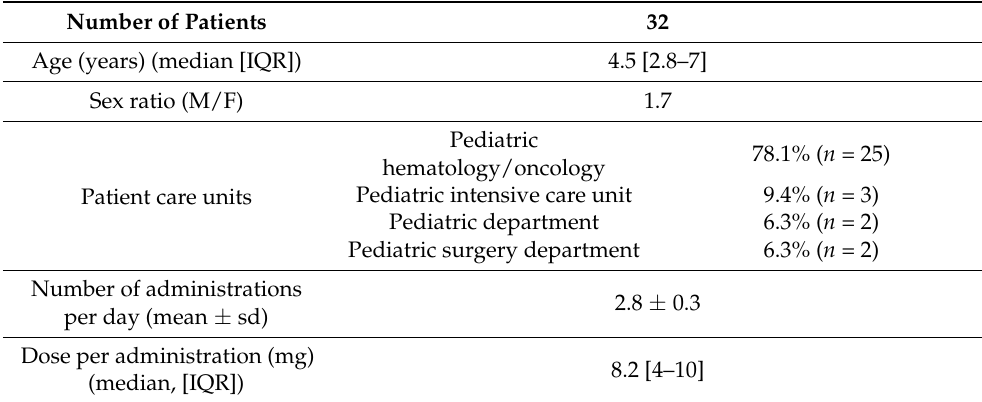
Table 1. Patients treated with the previous nicardipine hydrochloride 2 mg/mL oral